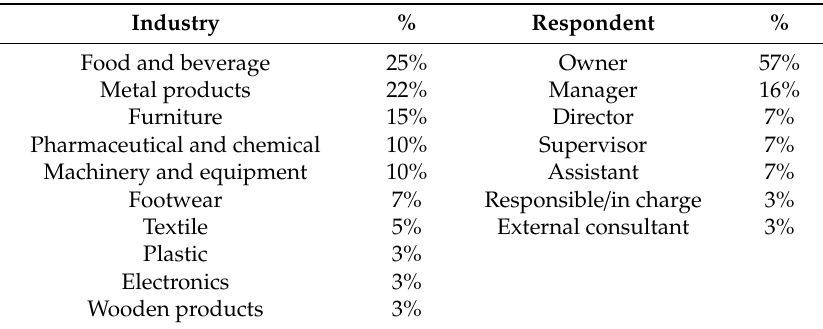
Table 3. Industry sector and respondents’